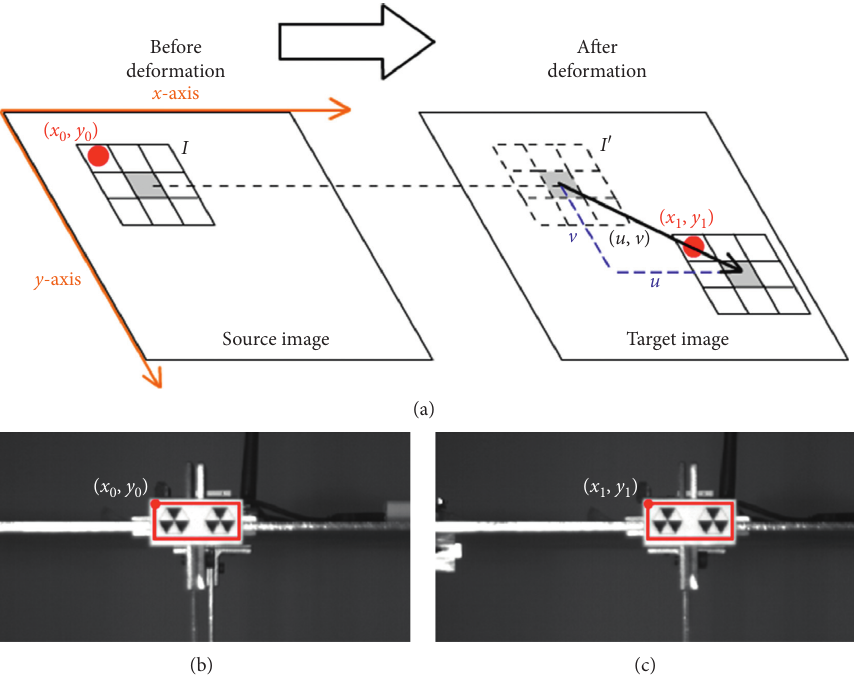
Figure 3: (a) Simplified diagram of source and target images, showing displacement variation of image block. (b) Source image. (c) Target image (reproduced from Lu et al. [15], under the Creative Commons Attribution license/public